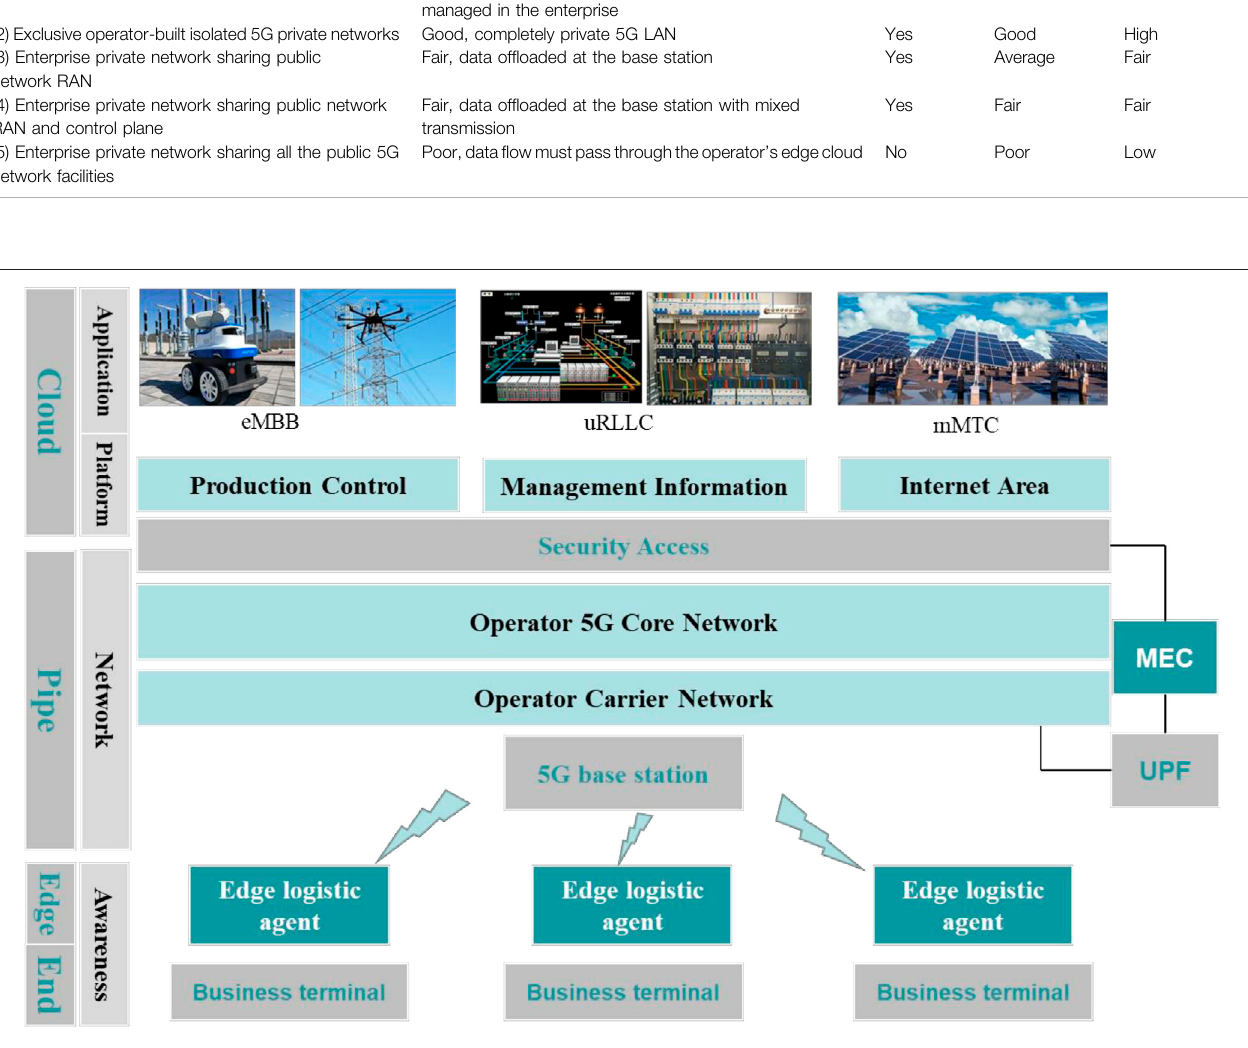
FIGURE 1 | A hybrid networking architecture of 5G and power communication